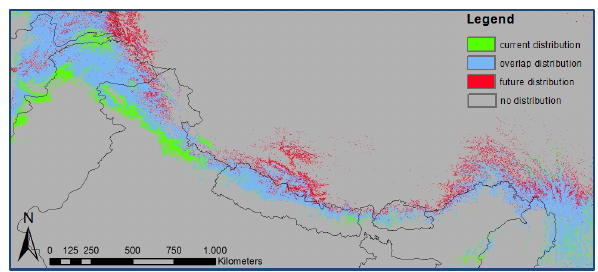
Figure 12. Potential range shift of Betula utilis under novel climate conditions in AD2070, based on ecological niche